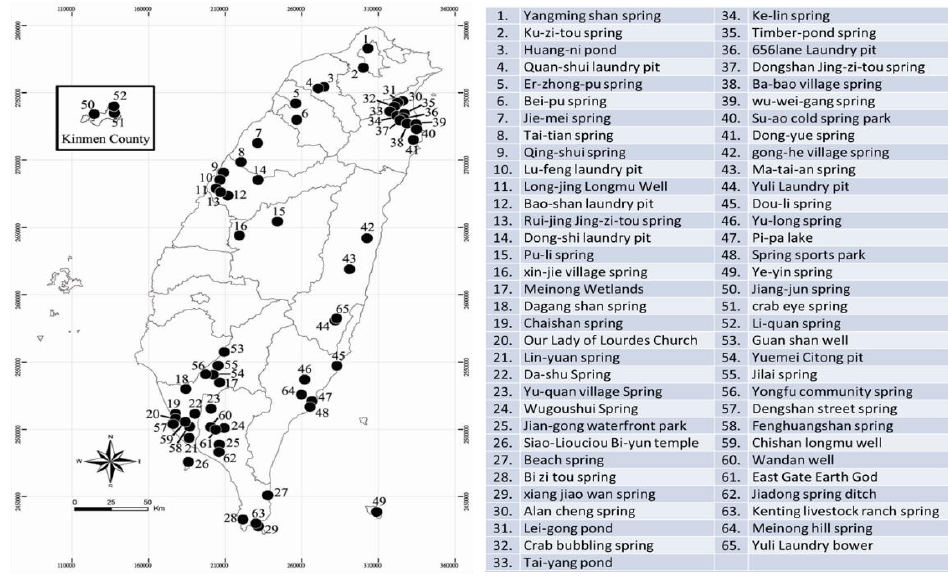
Figure 1. Locations of 65 visited springs in Taiwan.